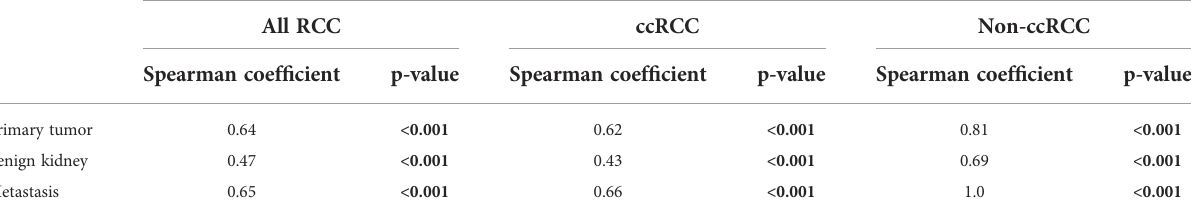
TABLE 3 Spearman correlation of iron levels in the tumor microenvironment (TME)/stroma versus epithelium of the same RCC patient tissue specimen. Tissue site